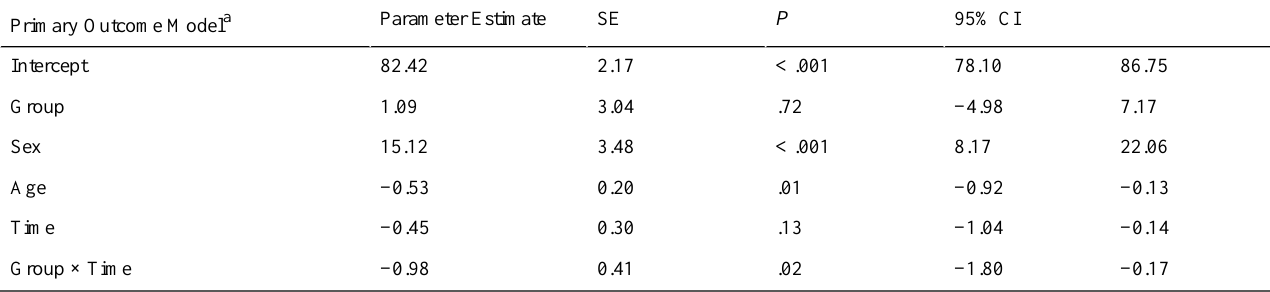
Table 4. Mixed-effects repeated-measures model parameter estimates for weight change